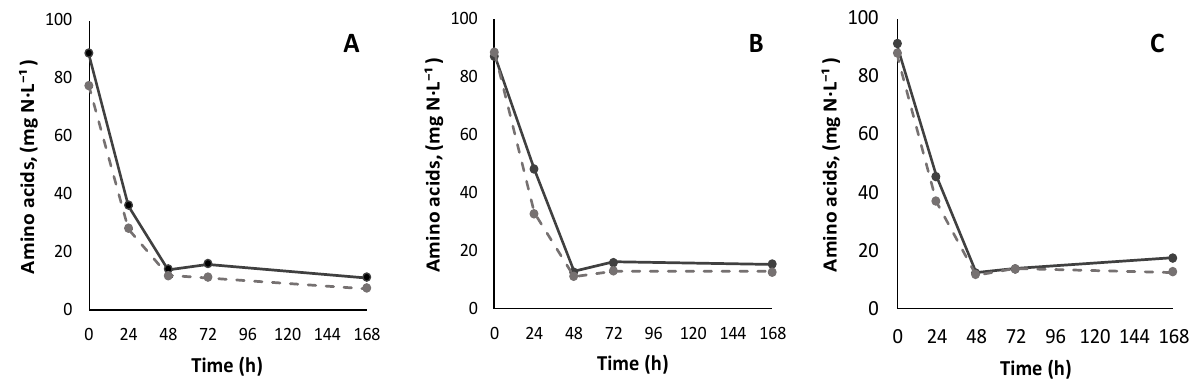
Figure 7. The relative consumption trends of 13 hexapeptides in fermentation with Lalvin ICV Opale 2.0™ ( A ), Lalvin Persy™ ( B ) and Lalvin QA23™ ( C ) of the modified synthetic must with added BSA hydrolysate as the peptide source. The five hexapeptide candidates with the highest abundance are shown in colour. Other hexapeptide candidate sequences and their observed relative consumption trends are shown in Table A8. *DTHKSE elutes within the void volume.